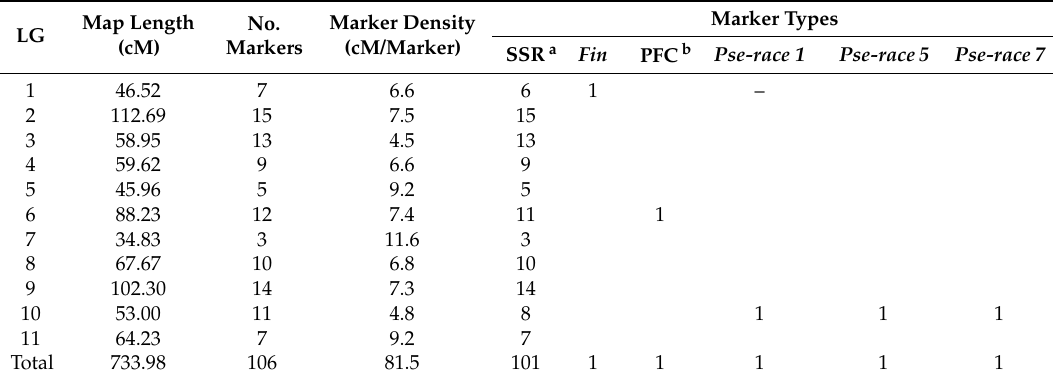
Table 4. Distribution of molecular markers on the consensus linkage map constructed from individual UI3T and UI3A52 F 2 maps.